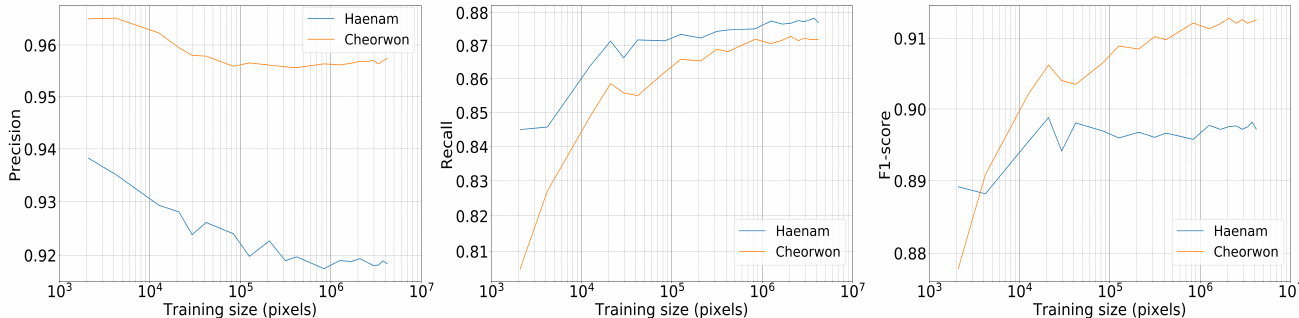
Figure 13. Precision, Recall and F-1 score of RF for varying training set size—for a feature space that includes acquisitions from June until the end of July—with depth = 12 and number of trees =